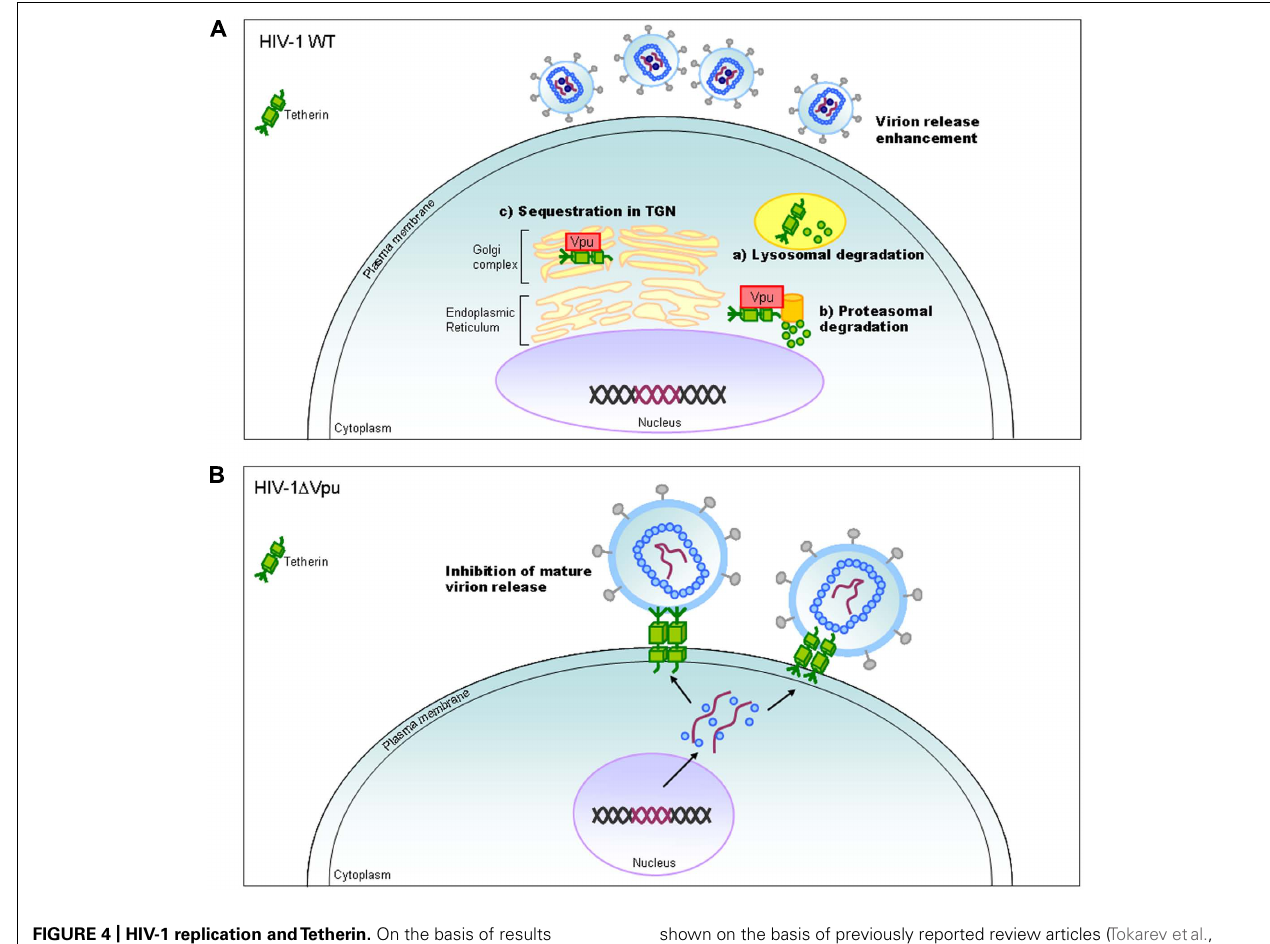
FIGURE 4 | HIV-1 replication andTetherin. On the basis of results reported so far, the action mechanism ofVpu is depicted. Replication process for wild-type (WT) and Δ Vpu mutant viruses are schematically